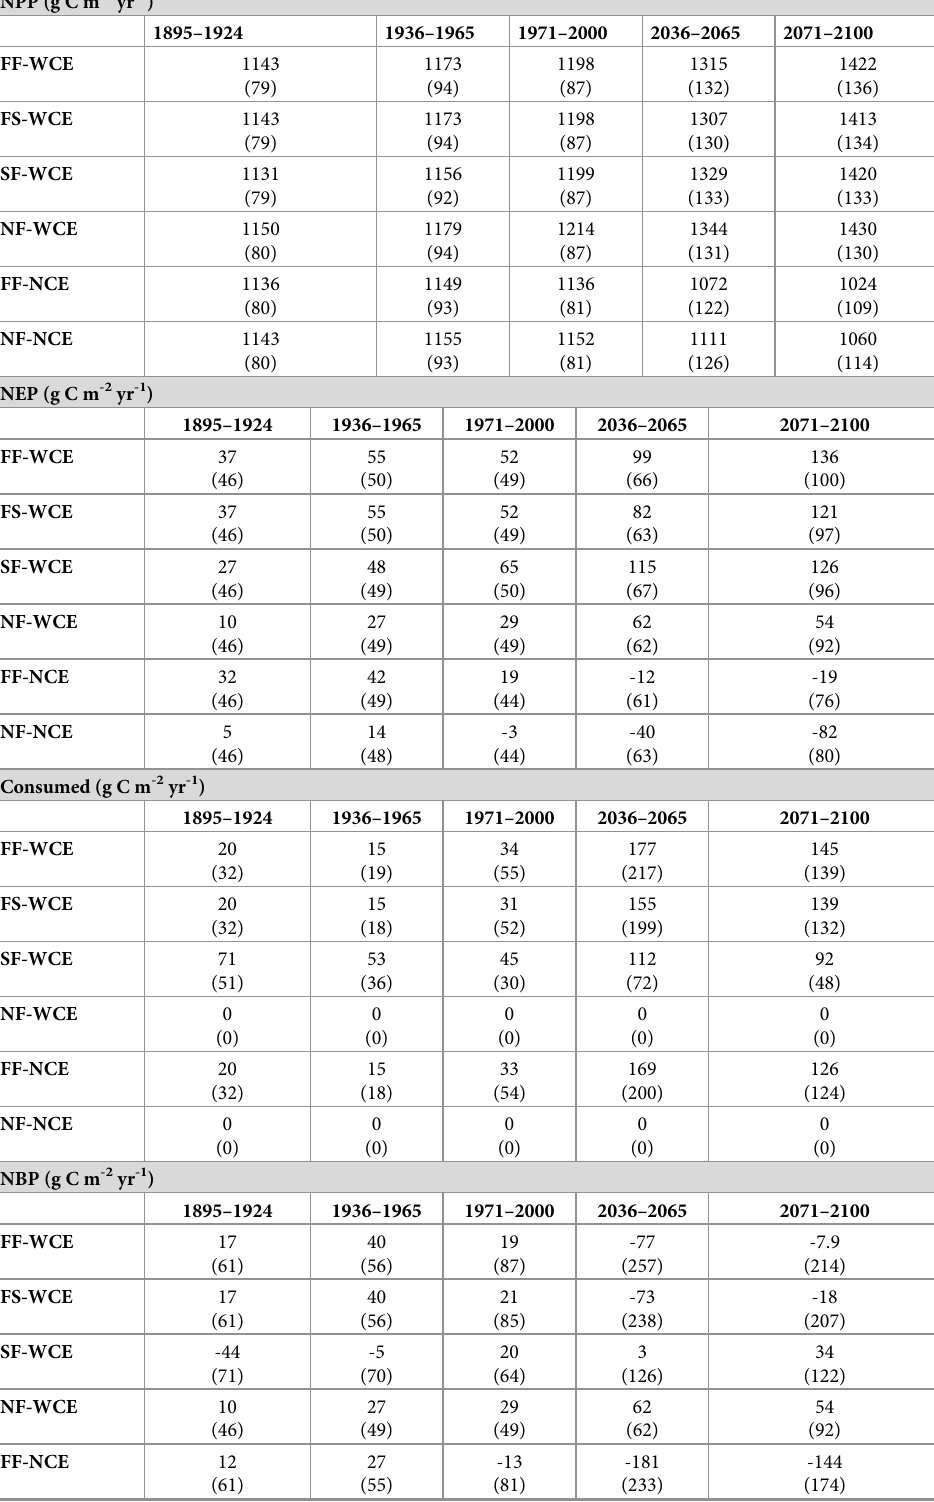
Table 6. Mean (standard deviation in parentheses) carbon fluxes by time period for simulation